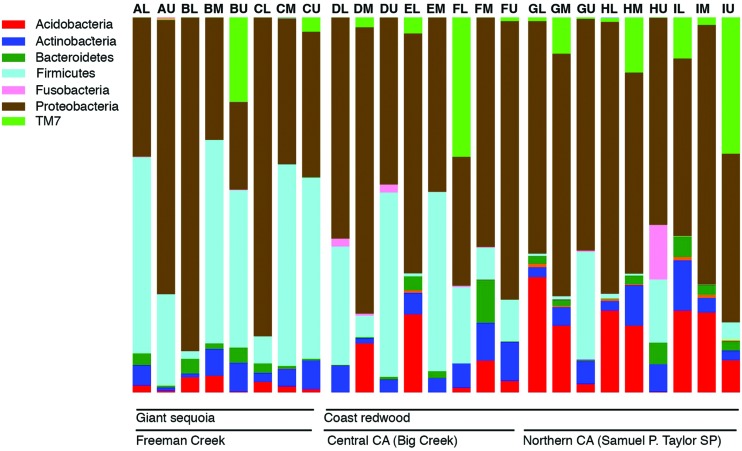
Bar chart showing the relative abundance of major phyla in all the samples as percentages of all 16S rRNA gene sequences recovered in our foliage samples. Each bar represents a sample, and letters A–I indicate individual trees (nine total), while L, M, and U indicate the canopy location from which the sample was taken (lower, middle, or upper).